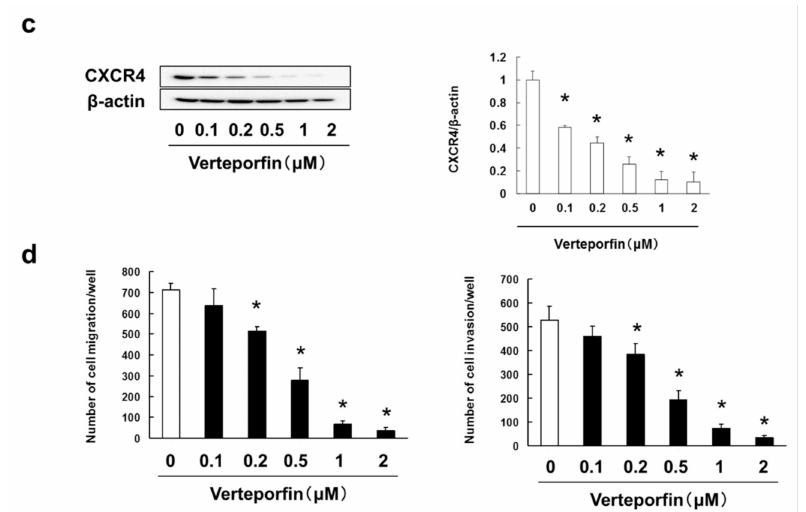
Figure 6. Verteporfin suppressed cell adhesion, and SDF-1-induced cell migration and invasion via inhibition of RHAMM and CXCR4 expression: ( a ) B16BL6 cells were treated with verteporfin at indicated concentration for 3 days. Images of Western blots for the RHAMM, CD44, and β -actin (internal standard), and quantification of the amounts of RHAMM and CD44 after normalization to the amounts of corresponding protein. The results are representative of 4 independent experiments. * p < 0.01 vs. controls (ANOVA with Dunnett’s test); ( b ) B16BL6 cells (1 × 10 4 cells), which had been